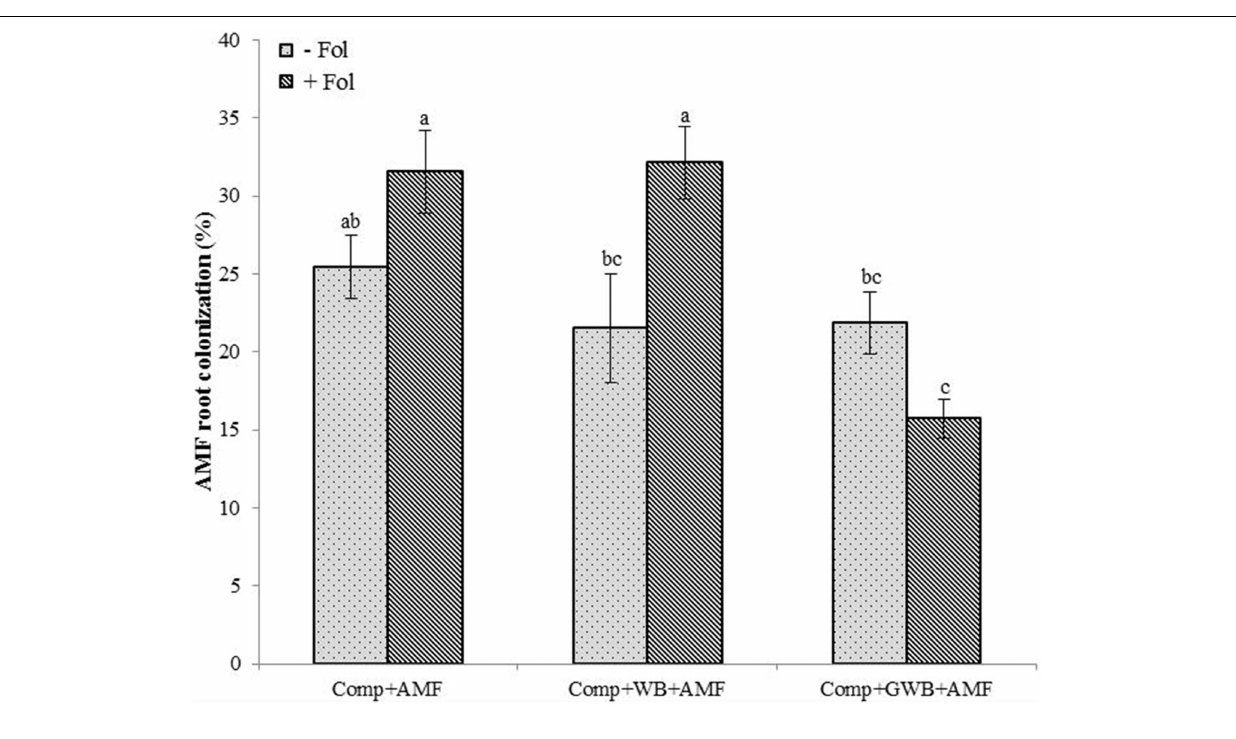
inoculated ( + Fol) on tomato plants root colonization by AMF. Each bar represent mean ± SE, n = 15 , bars with different letters indicate significant differences according to Tukey’s test ( P <